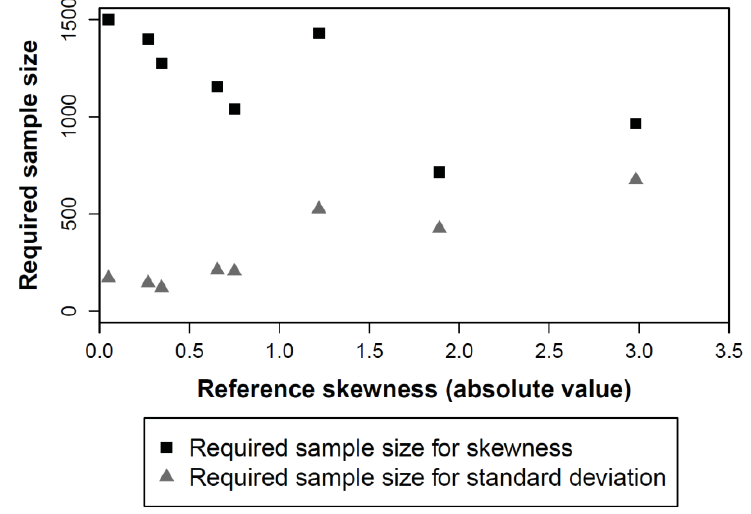
Figure 3. Relationship between sample size required for the estimation of standard deviation (triangles) and skewness (squares) and absolute values of the reference skewness. Required sample sizes refer to relative errors of less than 10% at 95%